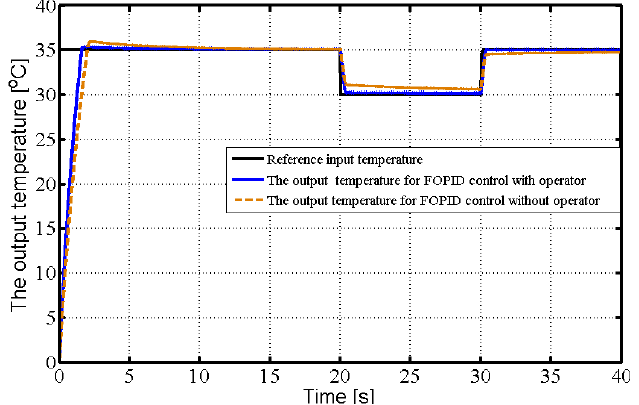
Figure 19. Tracking performance for the fractional-order spiral counter-flow heat exchanger.